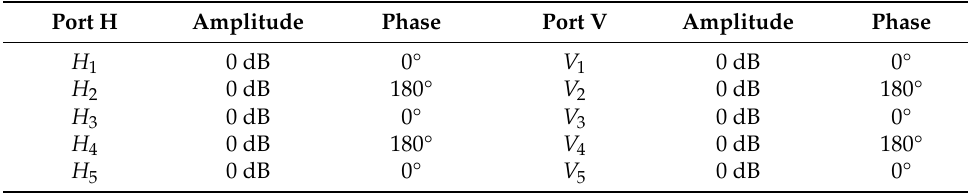
Table 4. Amplitude and phase values. Uniform. Array with 180°